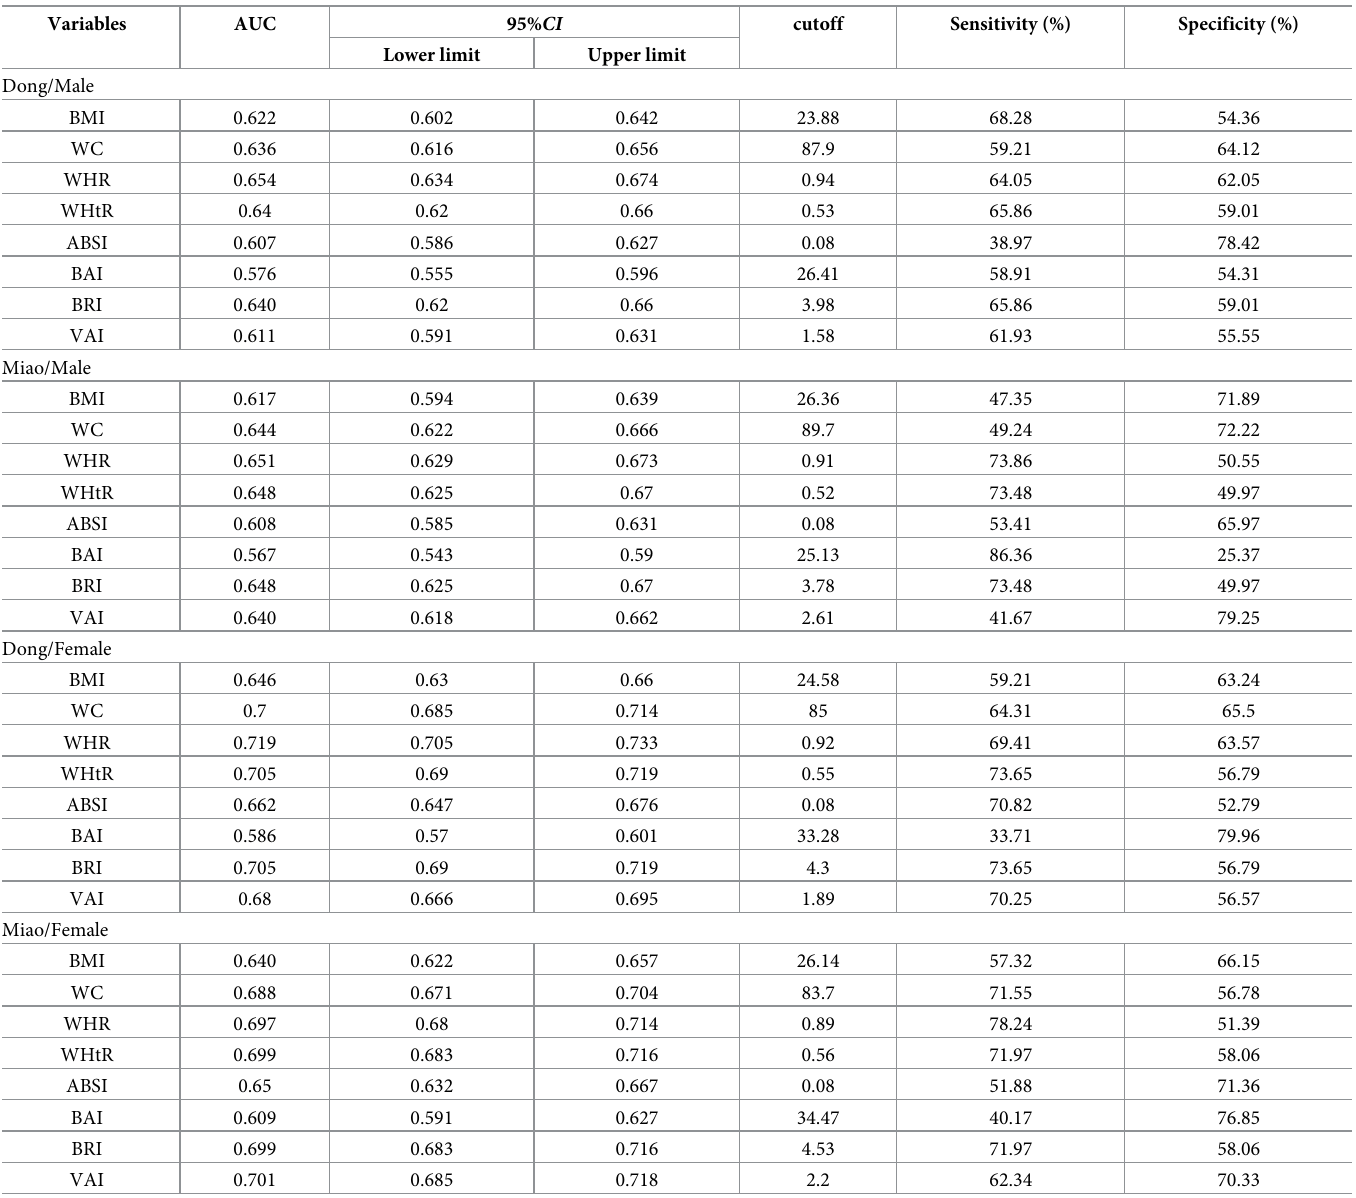
Table 3. Ability of obesity factors to predict diabetes (AUC and 95% CI